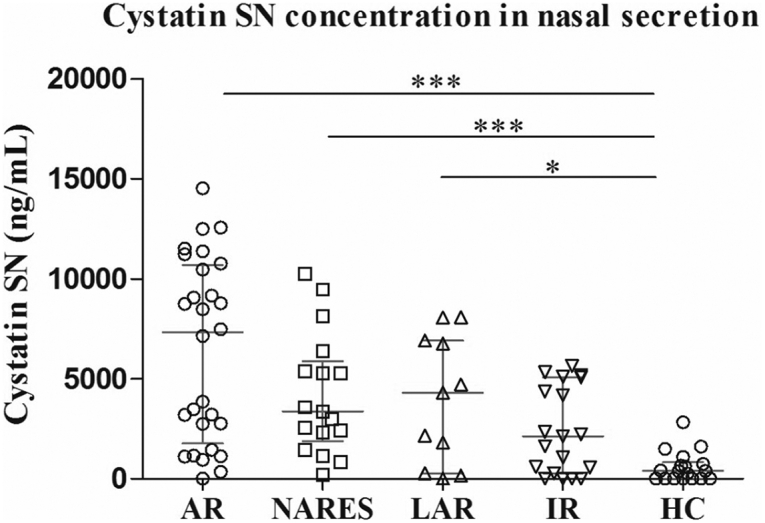
Measurements of Cystatin SN in the nasal fluid of patients with AR, NARES, LAR, and IR and control subjects. AR, allergic rhinitis; NARES, nonallergic rhinitis with eosinophilia syndrome; LAR, local allergic rhinitis; IR, idiopathic rhinitis; HC, health control. The data are presented as median ± interquartile range (IQR). ∗∗∗: p < 0.001. ∗: p < 0.05